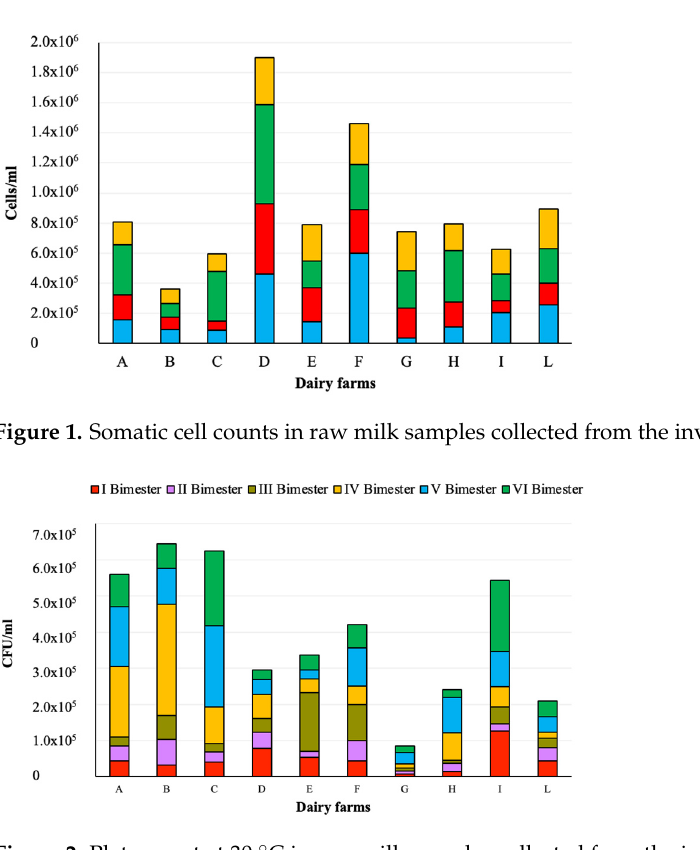
Figure 2. Plate count at 30 °C in raw milk samples collected from the investigated dairy farms. Table 1. Lipid and protein contents (mean ± S.D., %) in raw milk samples collected from the investigated dairy farms.